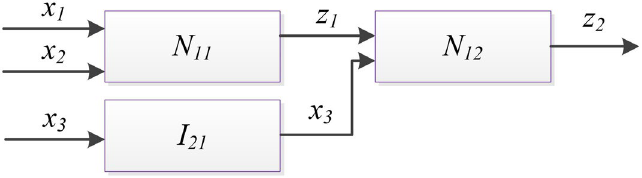
Figure 2. Hierarchical structure example for illustrating the basic operations in FN.